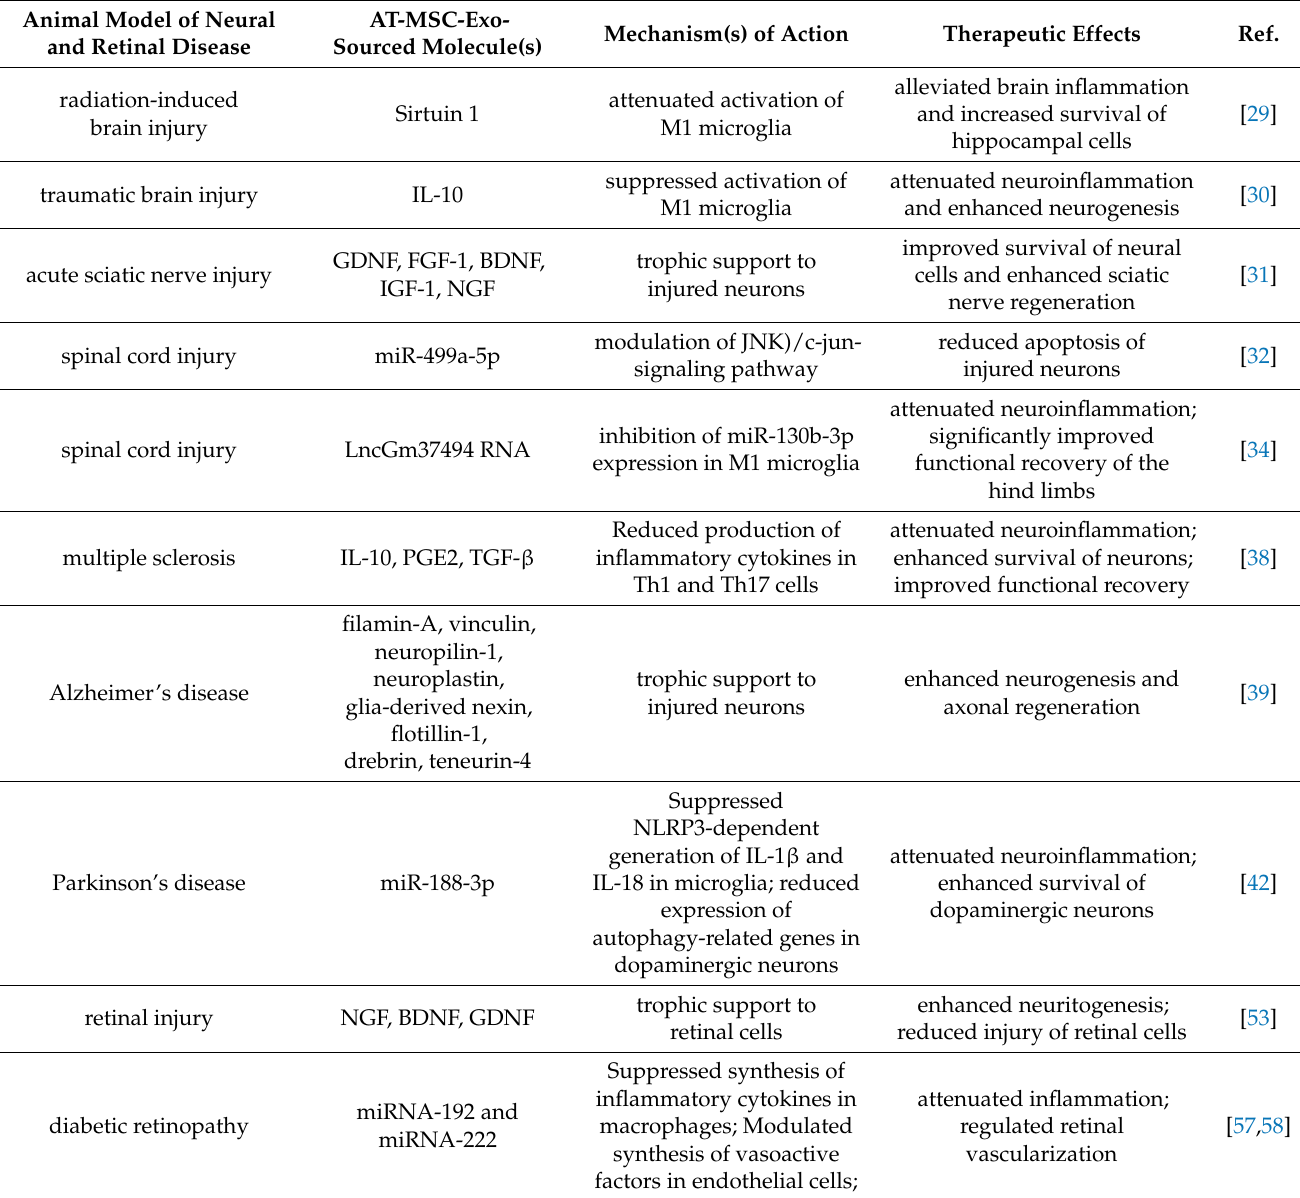
Table 2. Animal studies demonstrating therapeutic effects of AT-MSC-Exos in the treatment of neural and retinal